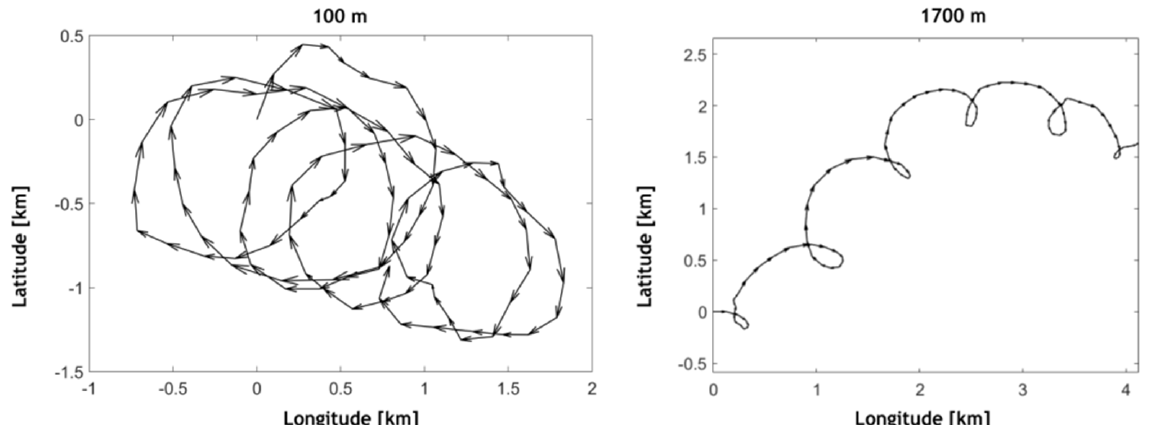
Figure 4. Progressive vector diagram of the currents at 100 m and 1700 m depths of ABS No. 1 from 00:00 20 January 2017 to 03:00 24 January 2017. The data were averaged over 1 h. The horizontal and vertical axes show the distances in longitude and latitude from the starting points of the data ensembles.